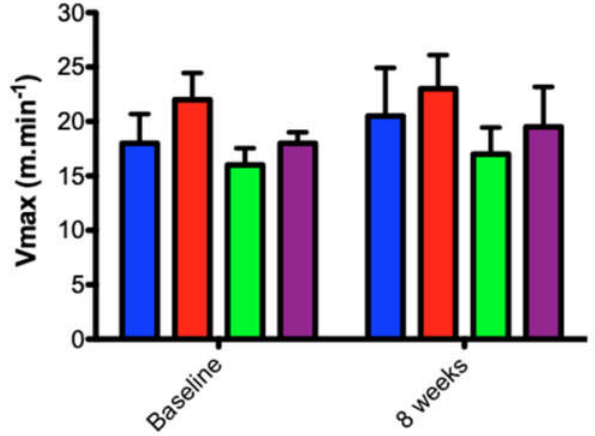
Figure 4. Incremental test. Two-way ANOVA revealed no significant differences between control and exercised groups (interaction, p > 0.05, diet, p < 0.05, and training, p < 0.05).